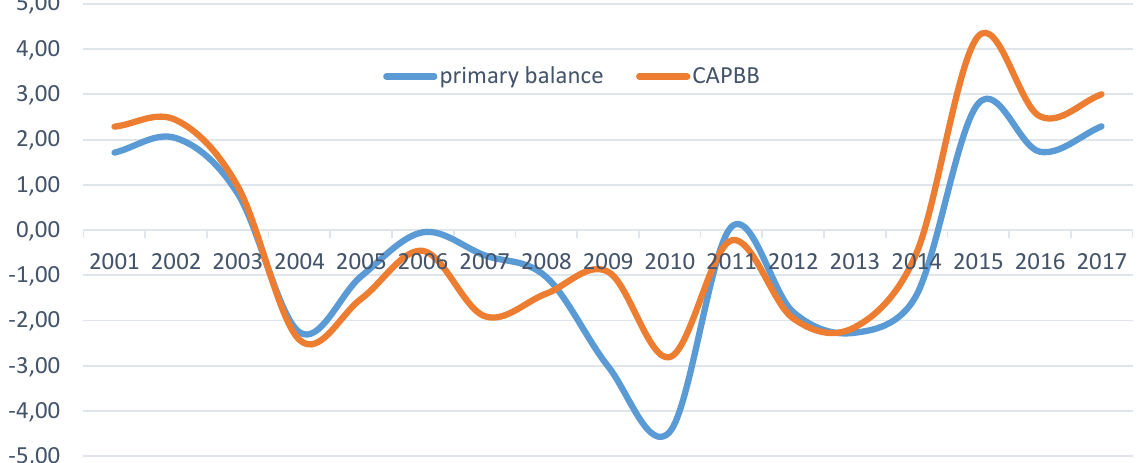
Figure 1. Primary deficit of consolidated budget in Ukraine over the period 2001–2017, % to